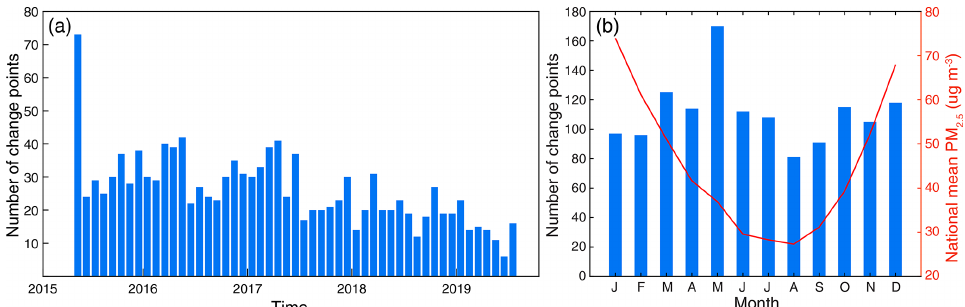
Figure 4. Temporal variations of the number of change points detected in (a) each specific month from 2015 to 2019 and (b) each month of the year. National mean PM 2 . 5 concentration in each month of the year was calculated based on PM 2 . 5 data measured at our selected 1309 sites during 2015–2019.